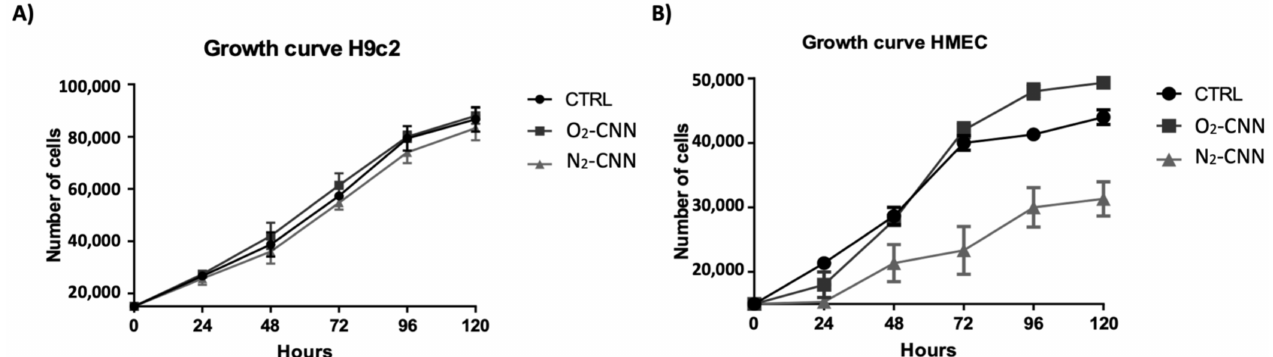
Figure 5. Growth curves of the two cell models. ( A ): Treatment of H9c2 with O 2 -CNN or N 2 -CNN at 10 µ g/mL compared to the untreated control group (CTRL). ( B ): Treatment of HMEC with O 2 -CNN or N 2 -CNN at 10 µ g/mL compared to the untreated control group (CTRL). Data were expressed as mean ± SE.